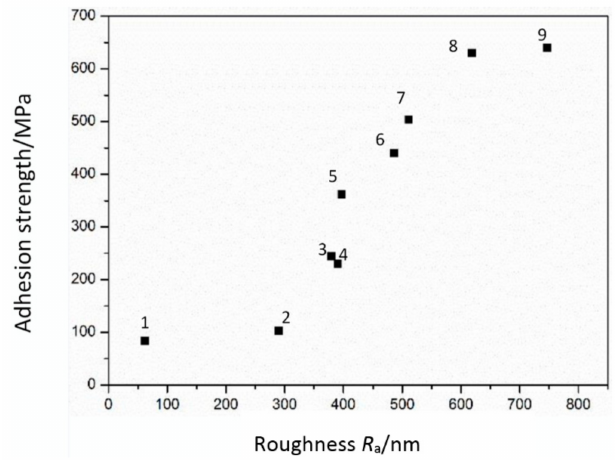
Figure 8. Relationship between the adhesion strength and surface roughness of the metal Ni films.